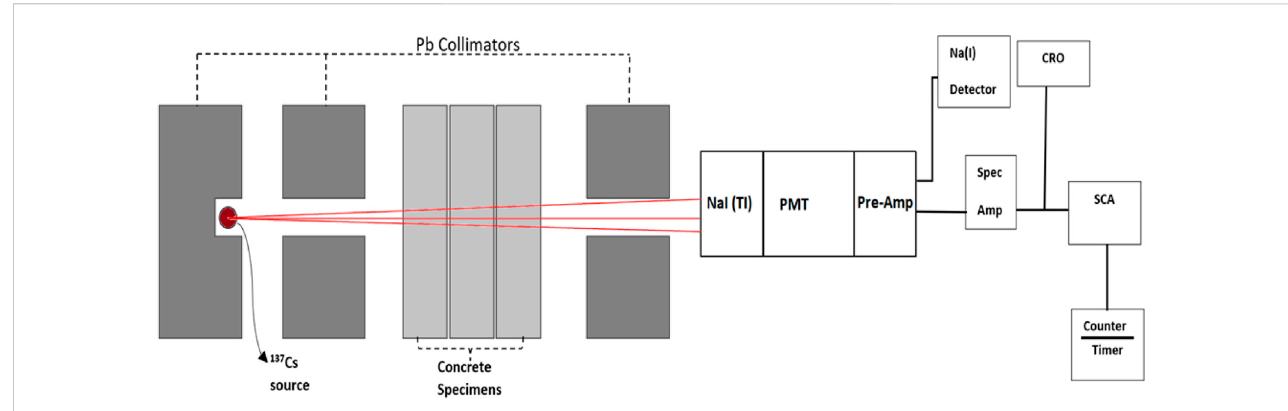
FIGURE 4 Systematic setup of gamma ray